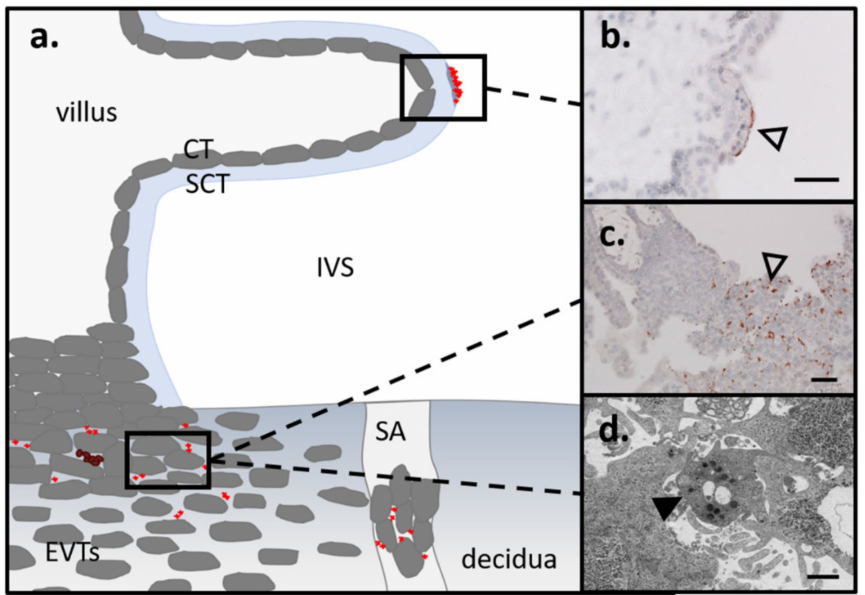
Figure 2. Interaction of maternal platelets with trophoblasts in the first trimester placenta. ( a ) Scheme of first trimester anchoring villus shows the location of maternal platelets based on recent immuno- histochemistry and transmission electron microscopy (TEM) data. With immunohistochemistry for platelet marker CD42b, platelets were found (open arrowheads) on ( b ) perivillous fibrin depositions and ( c ) in intercellular gaps between EVTs of anchoring trophoblast columns. ( d ) The presence of platelets between EVTs was further verified by TEM (platelet shown by arrowhead). Scale bars of b and c represent 50 µ m. Scale bar of d represents 1 µ m. EVT: extravillous trophoblast; IVS: intervillous space; CT: cytotrophoblast; SCT: syncytiotrophoblast; SA: spiral